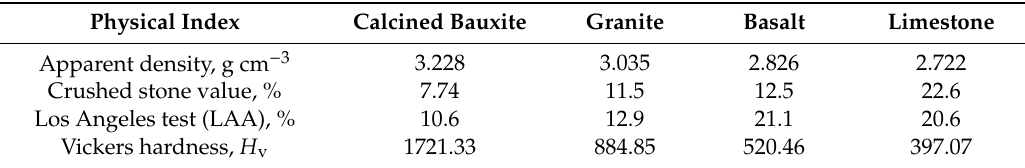
Table 1. Properties of the test aggregates.